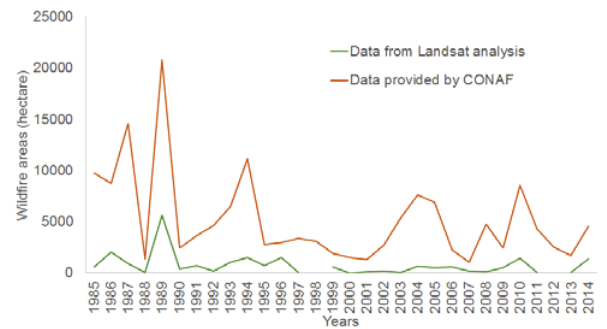
Figure 7. Surface affected by wildfires by historical